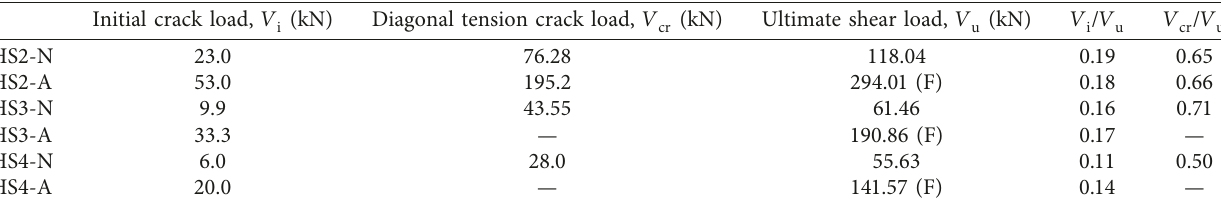
Table 15: Shear load of UHPC shear